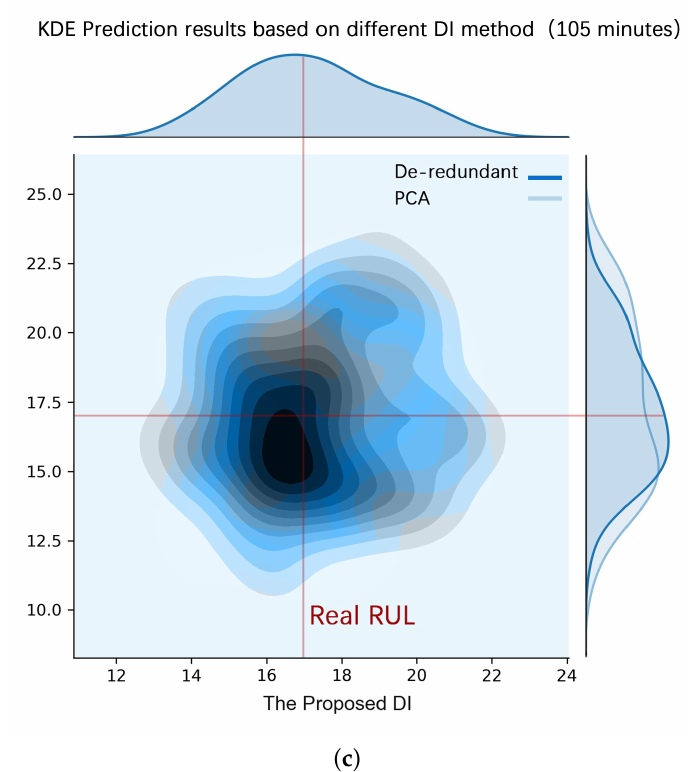
Figure 14. KDE prediction results at different operating moment. ( a ) deterministic KDE prediction results at the moment of 75 min, ( b ) deterministic KDE prediction results at the moment of 90 min, ( c ) deterministic KDE prediction results at the moment of 105